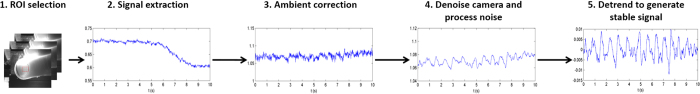
Overview of the processing steps for the proposed PPGI system.Upon acquiring frames, ambient correction using TCI is performed, which removes temporal changes in ambient illumination from the frames. This is followed by denoising to remove camera sensor noise and process noise from the light-tissue interaction, and smooth motion detrending. The resulting signal is an extracted stable PPGI signal.